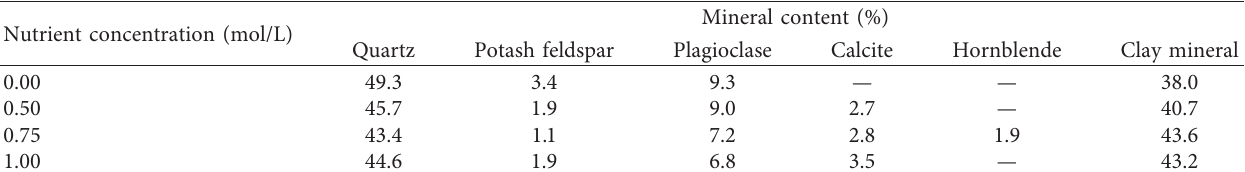
Table 3: Ordinary nonclay mineral abundances in MICP-treated and cured soft clay specimens. Nonclay abundances were calculated from X-ray diffraction patterns.